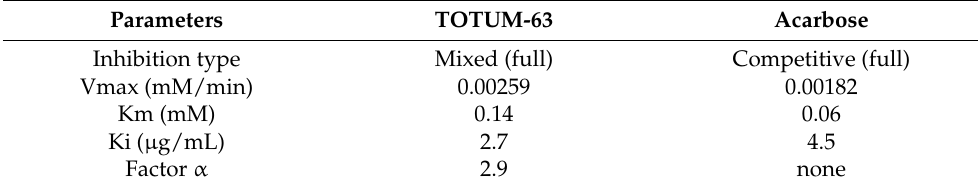
Table 4. Kinetic parameters of α -glucosidase inhibition in the presence of TOTUM-63 or acarbose. Parameters TOTUM-63 Acarbose Inhibition type Mixed (full) Competitive (full) Vmax (mM/min) 0.00259 0.00182 Km (mM) 0.14 0.06 Ki ( µ g/mL) 2.7 4.5 Factor α 2.9